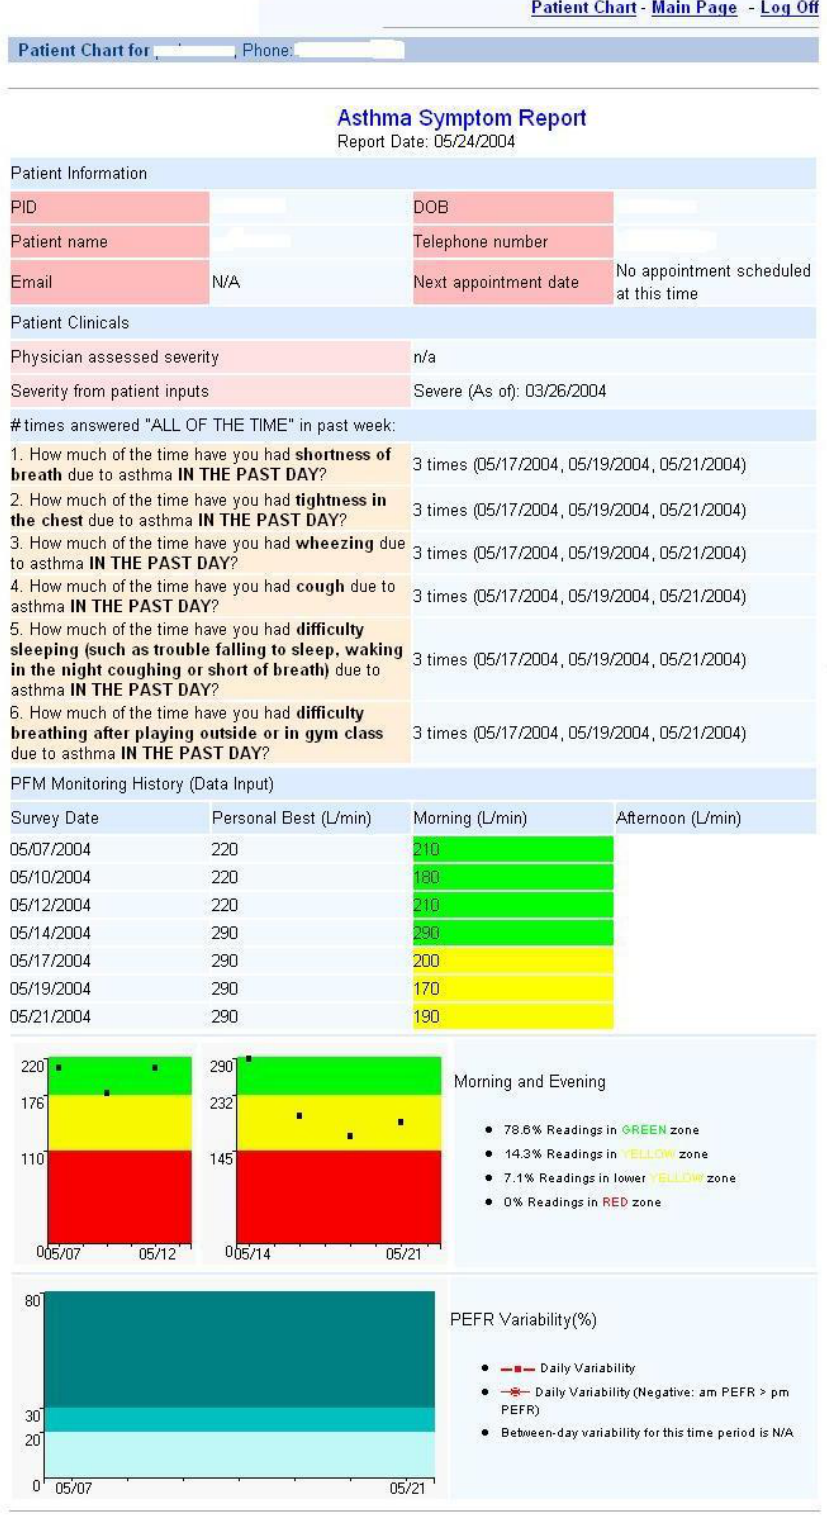
Figure 2. Asthma Intervention Report (AIR) Symptom